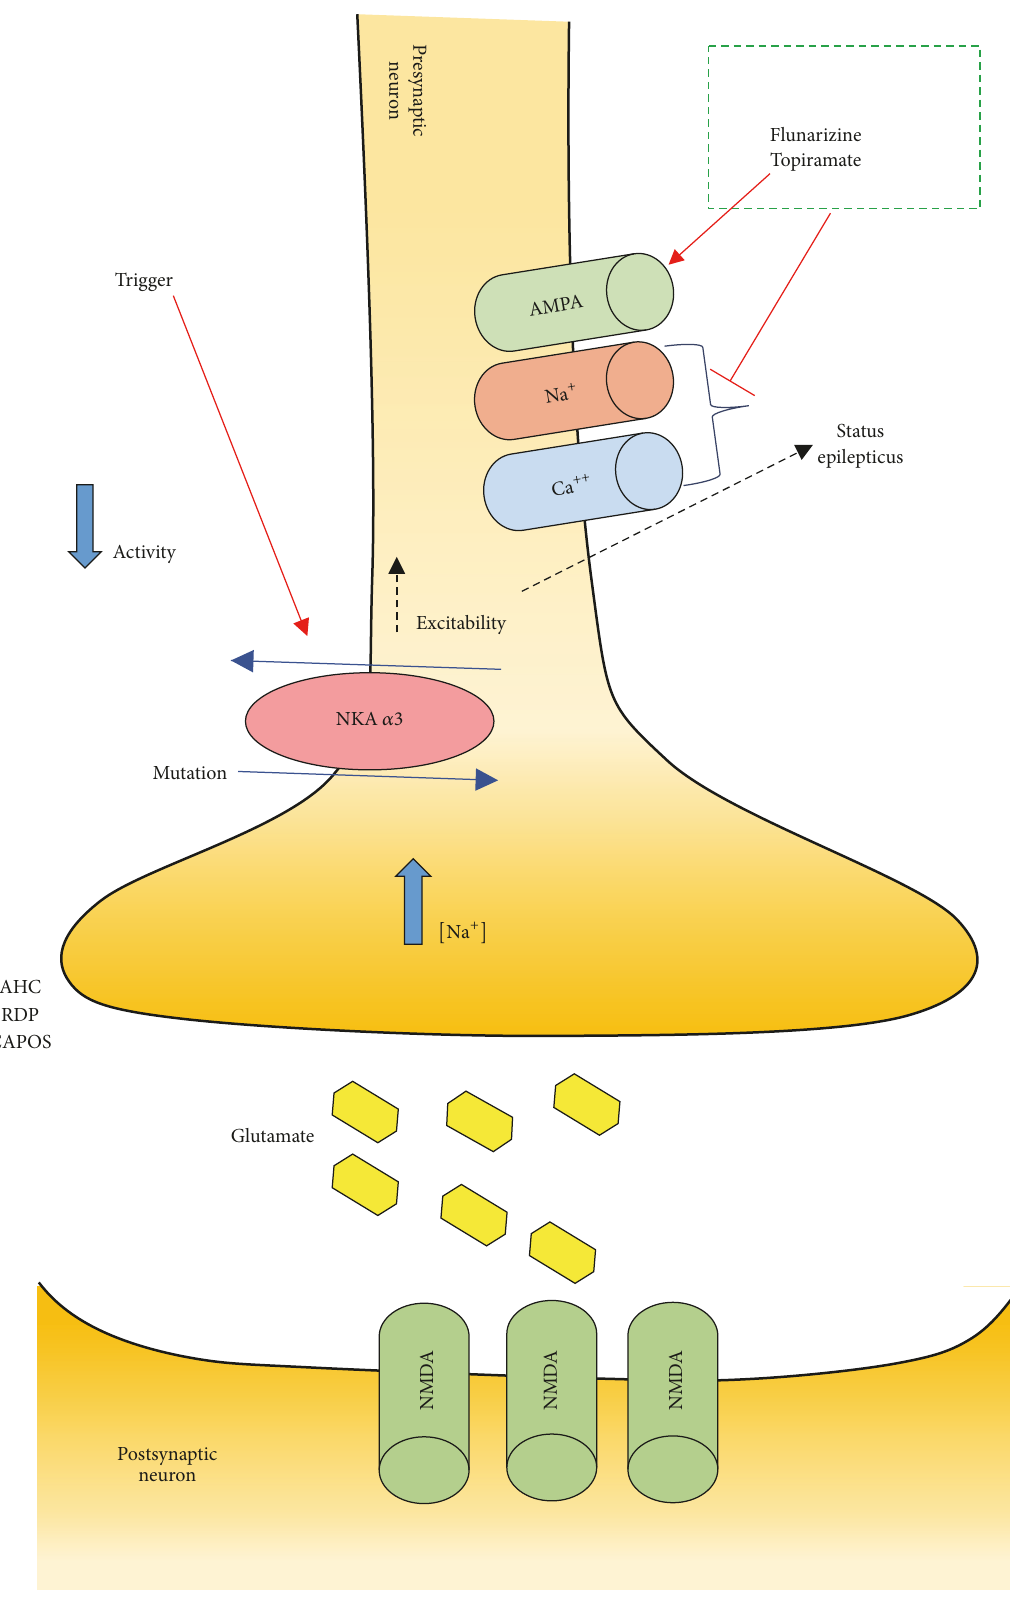
Figure 2: Schematic representation showing dysfunctional Na + /K + -ATPase pump activity due to ATP1A3 mutation in neurons affecting glutamatergic system activity. Mutation in ATP1A3 causes a decrease in Na + /K + -ATPase pump activity and an increase in intracellular Na + , which result in hyperexcitability that affects neuronal function. Flunarizine and topiramate are shown as treatment options for the conditions caused by this